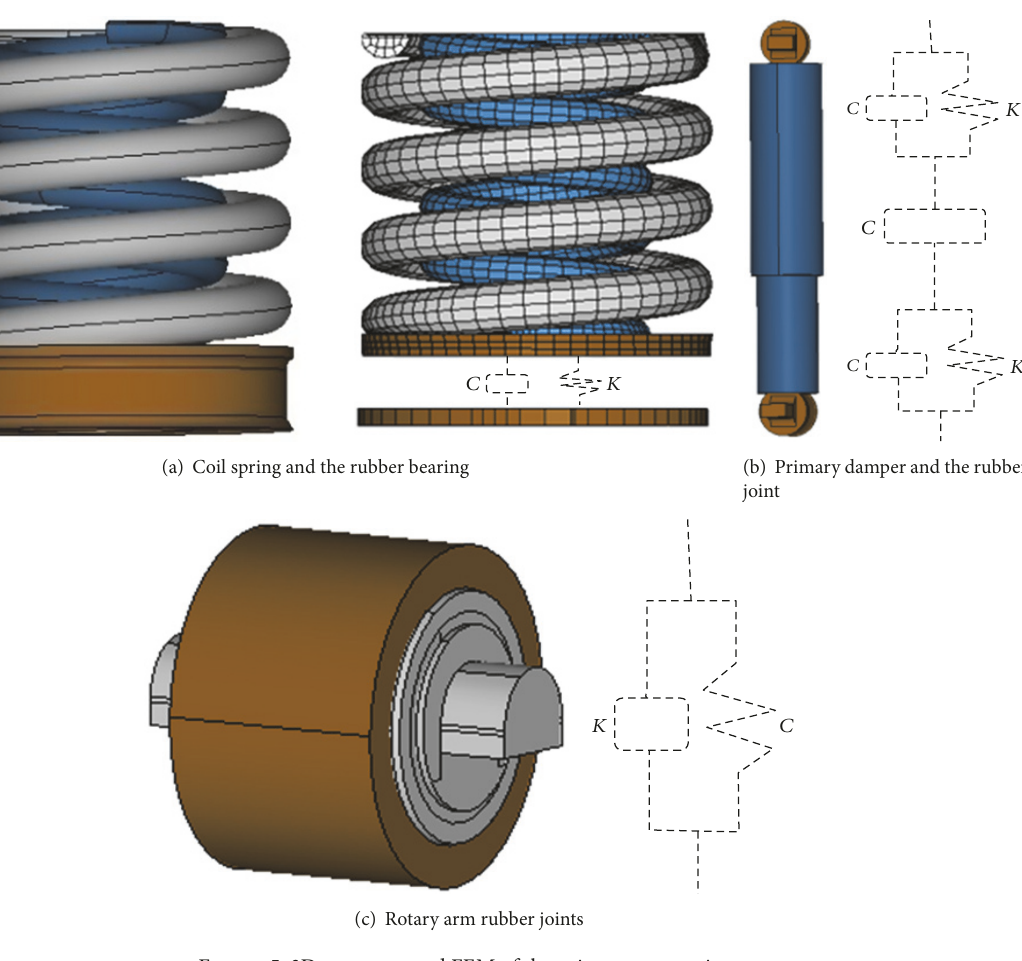
Figure 5: 3D geometry and FEM of the primary suspension.